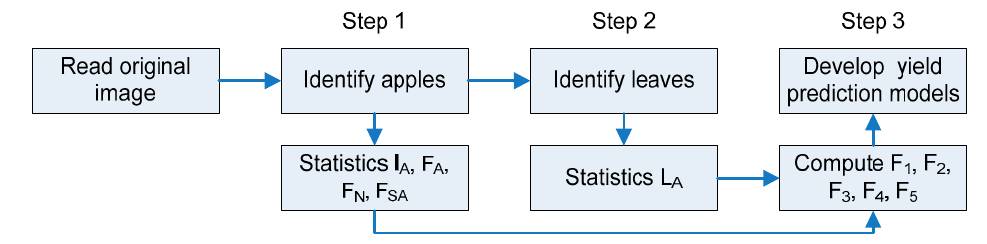
Figure 2. Outline of the processing steps.